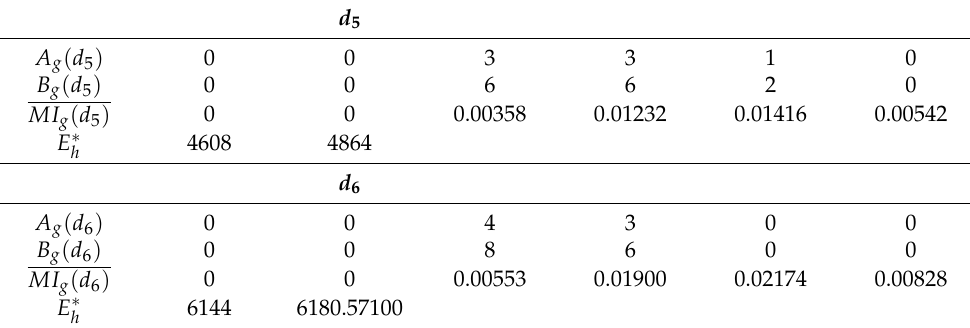
Table 3. Numerical results of Example